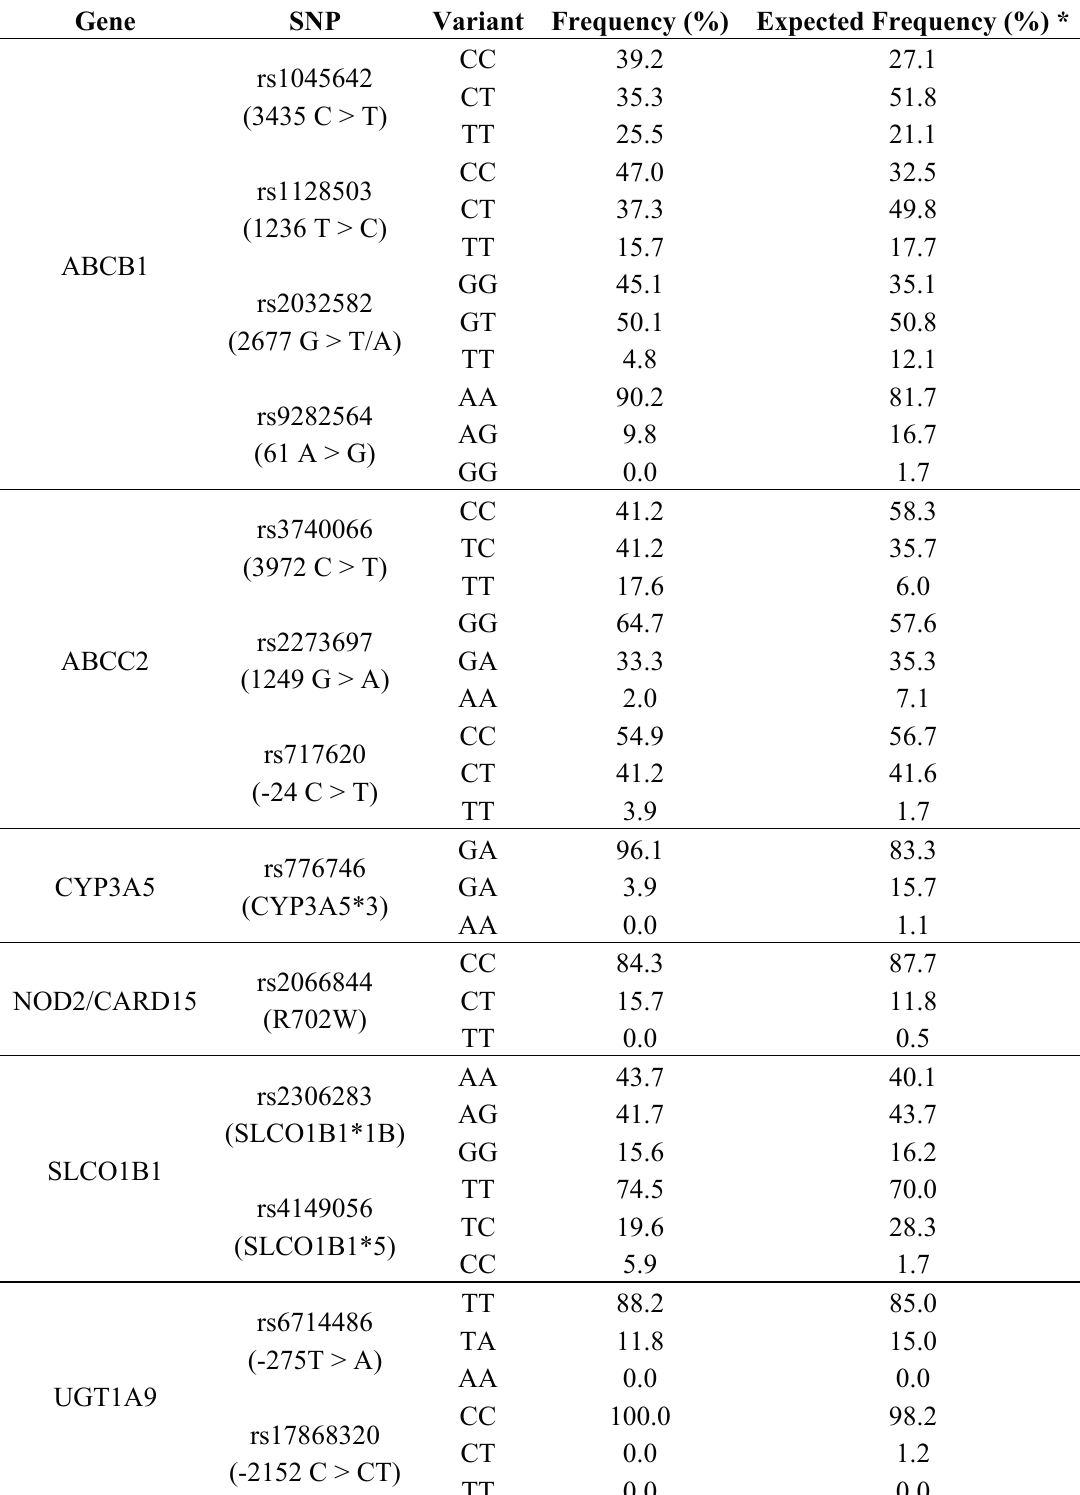
Table 2. Frequency of genotypes of the SNPs included in the study ( n = 51